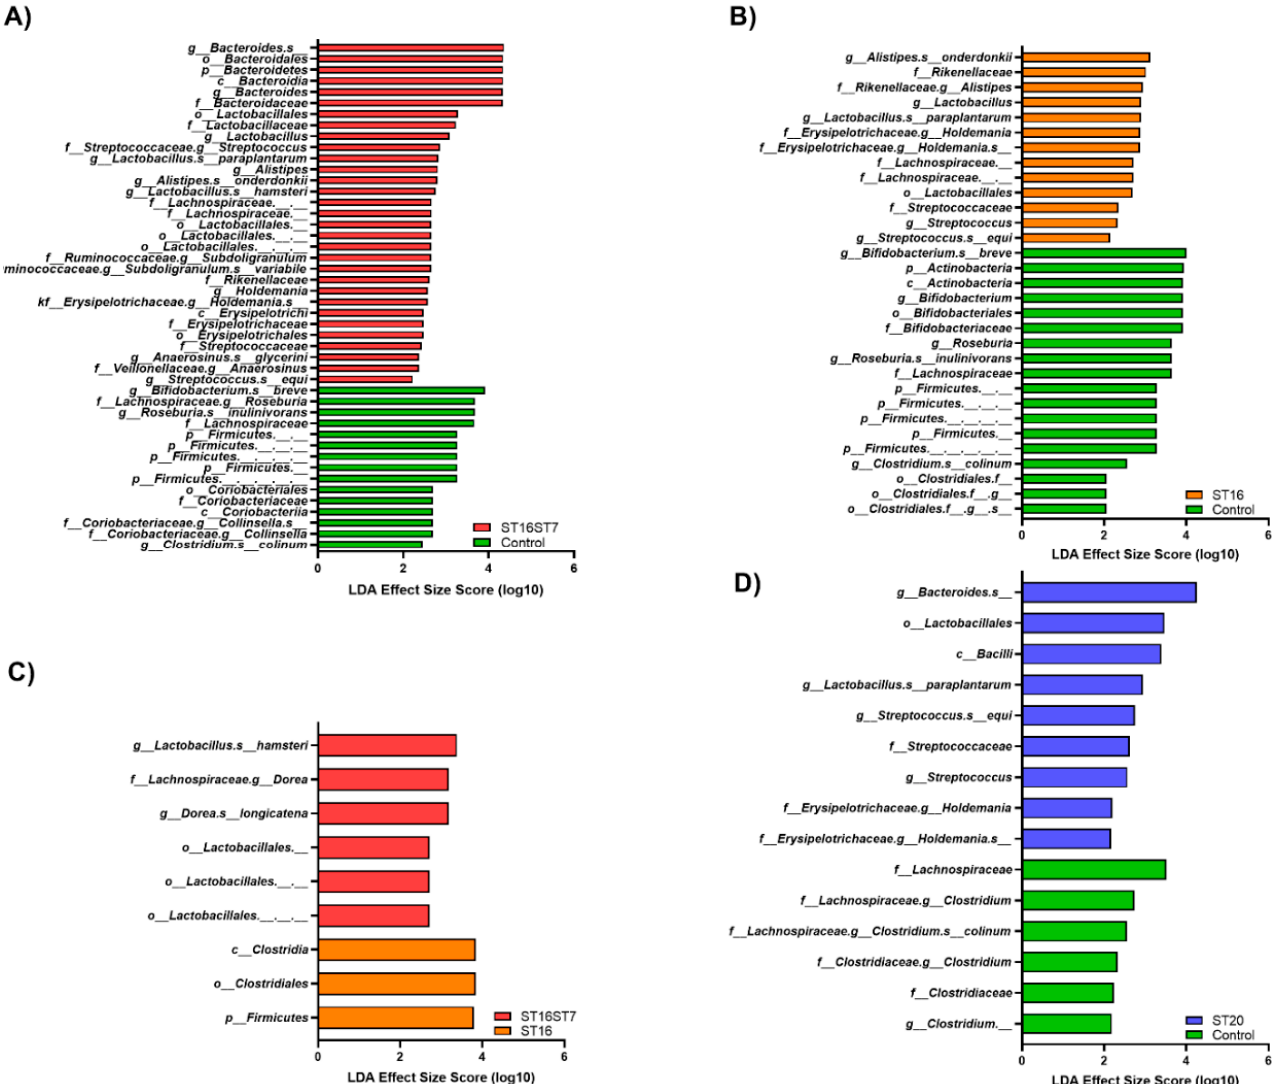
Figure 5. The test probiotic candidates modulating gut microbiota composition. ( A – D ) Histograms of the linear discriminant analysis (LDA) scores showing microbial taxa that vary significantly in abundance between: ( A ) no-treatment control and test treatment of the combination of L. bulgaricus and S. thermophilus , ( B ) no-treatment control and test treatment of S. thermophilus, ( C ) compare test treatment of S. thermophilus and combination of L. bulgaricus and S. thermophilus , ( D ) no-treatment control and test treatment of B. animalis